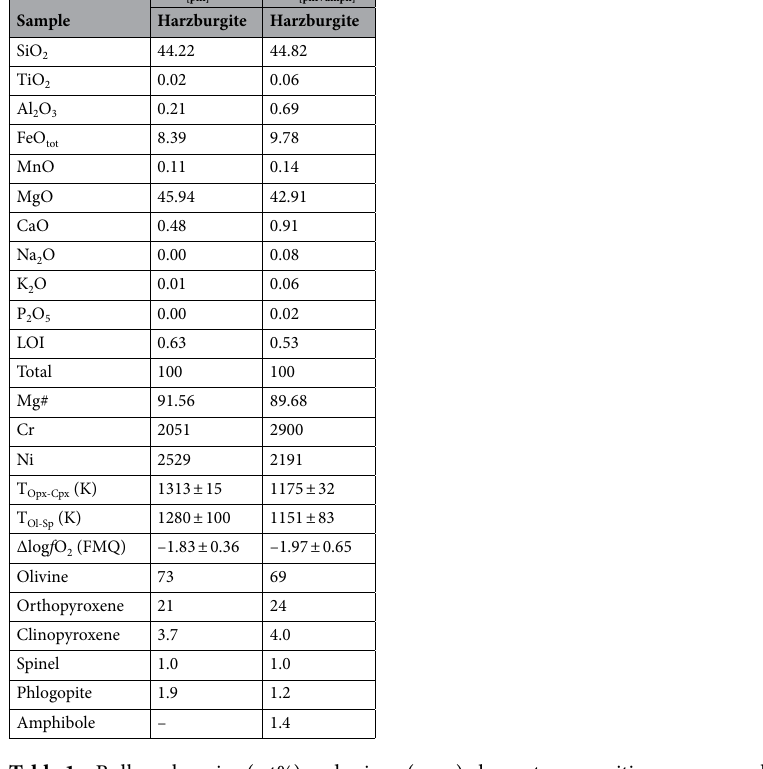
Table 1. Bulk rock major (wt%) and minor (ppm) element compositions; average phase proportions (%); geothermal and oxygen fugacity estimates of the Mt. Leura (LE) peridotite xenoliths. Average temperature ( T ) and oxygen fugacity (Δlog f O 2 ) for LE harzburgites are calculated at 2 GPa. Estimated temperatures are from the two-pyroxene geothermometer of Brey and Köhler 36 , and olivine-spinel geothermometers of Ballhaus et al. 37 and Jianping et al. 38 . Δlog f O 2 (FMQ) is calculated from the method of Wood 39 using Brey and Köhler 36 temperature and it is reported as difference (Δ) with respect to Fayalite-Magnetite-Quartz (FMQ) buffer 40 . Uncertainties are reported. Mg# = 100 × Mg/(Mg + Fe) mol